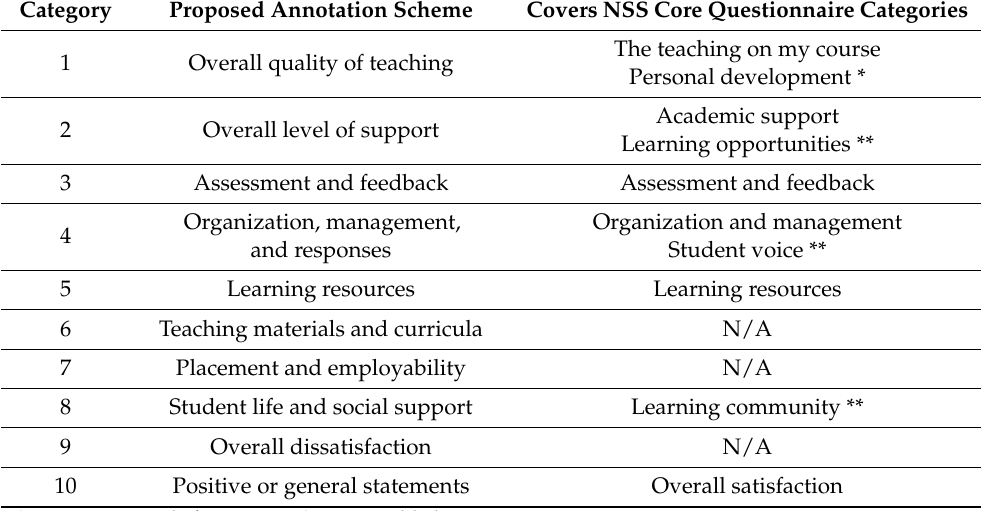
Table 1. Annotation scheme of problem statement categories used in this study and how it covers the NSS